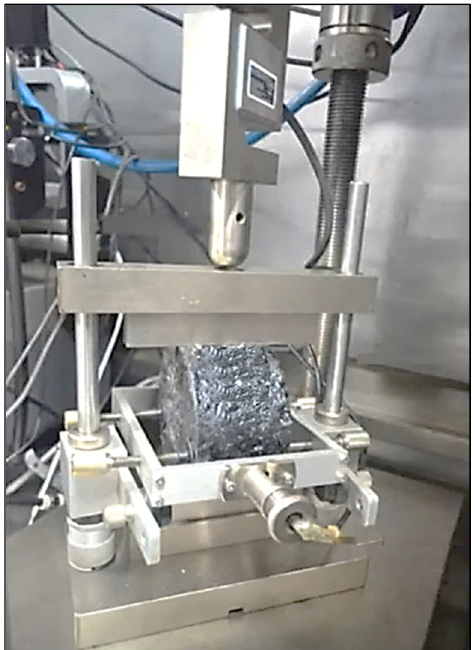
Figure 11. M R test apparatus. Figure 11. M R test